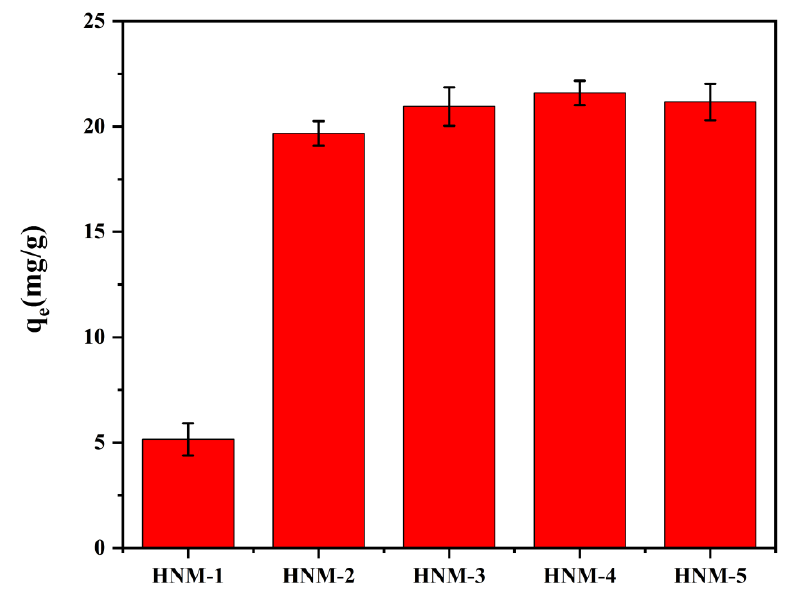
Figure 6. Adsorption capacities of HNM-1, HNM-2, HNM-3, HNM-4, and HNM-5 for SO 42 − .